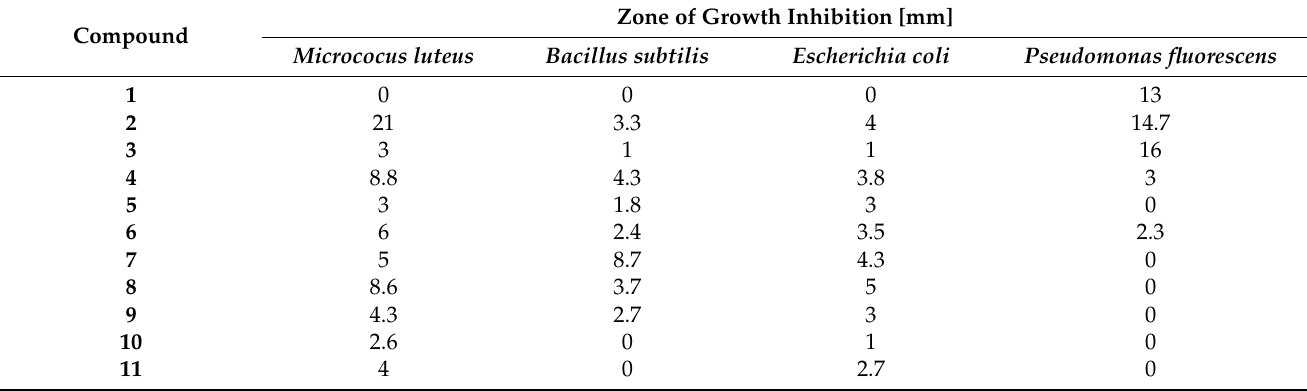
Table 3. Antibacterial activities of compounds 1 – 11